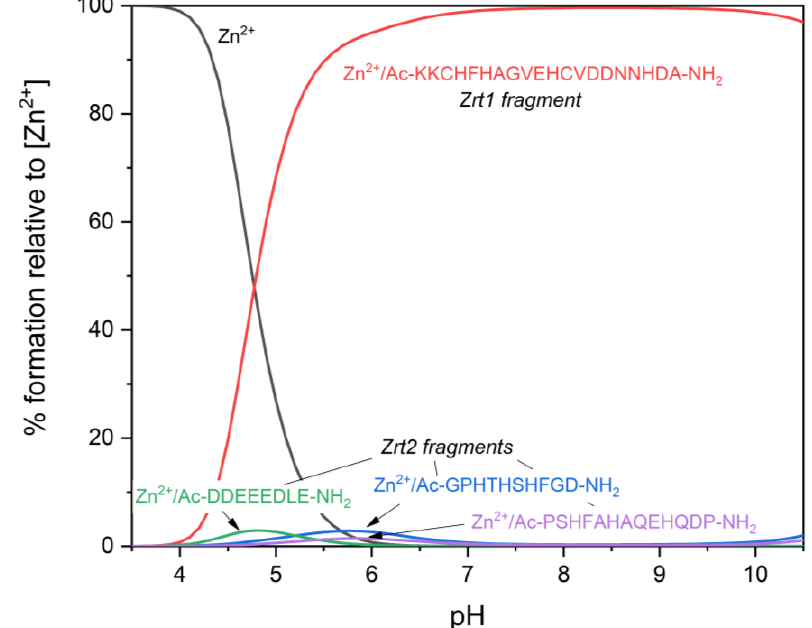
Figure 7. Competition plots for a solution containing equimolar concentrations (1 × 10 − 3 M) of Ac-KKCHFHAGVEHCVDDNNHDA-NH 2 (fragment from Zrt1), L1, L2, L3 (fragments from Zrt2) and Zn 2+